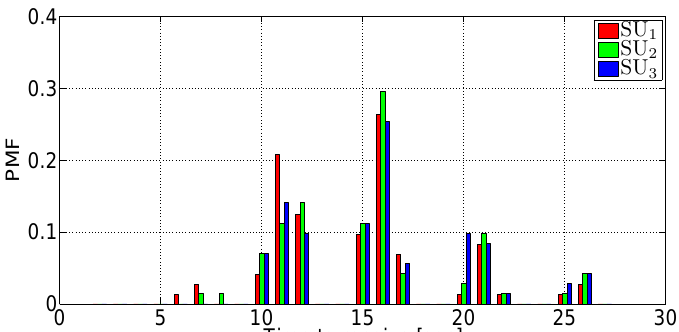
Figure 19. PMF of the archive reception time in Scenario